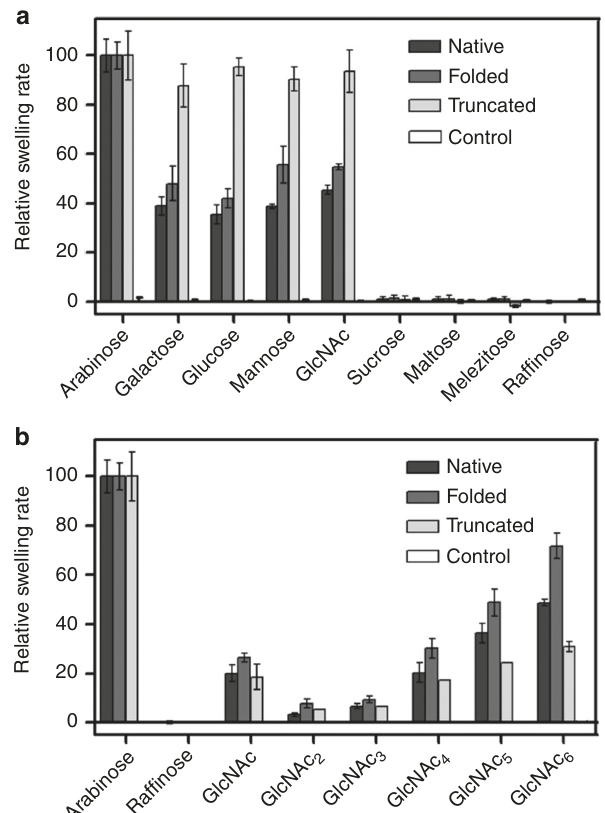
Fig. 10 The N-terminus is important for chito-oligosaccharide substrate transport. Proteoliposome swelling assays in the presence of various mono- and oligosaccharides ( a ) as well as chito-oligosacharides of different lengths ( b ). No permeation of any sugars was observed when tested with control liposomes without Vh ChiP. “ Folded ” denotes in vitro-folded Vh ChiP. Data represent mean ± s.d., n = 3. For details see